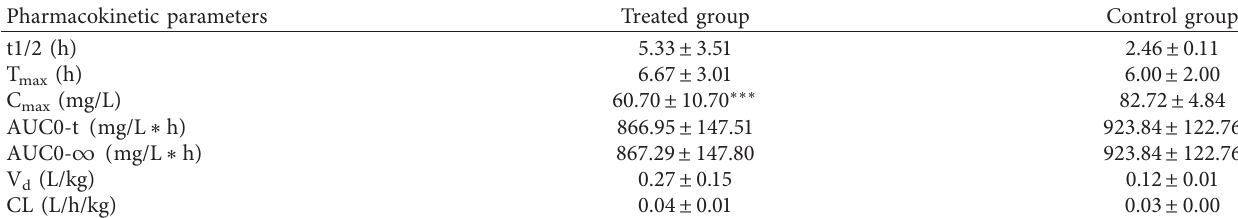
Table 7: Pharmacokinetic parameters of tolbutamide in the treated group and control group.